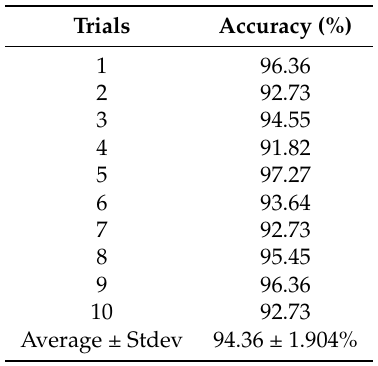
Table 2. Accuracy results for 10 runs on Model 2, Fold